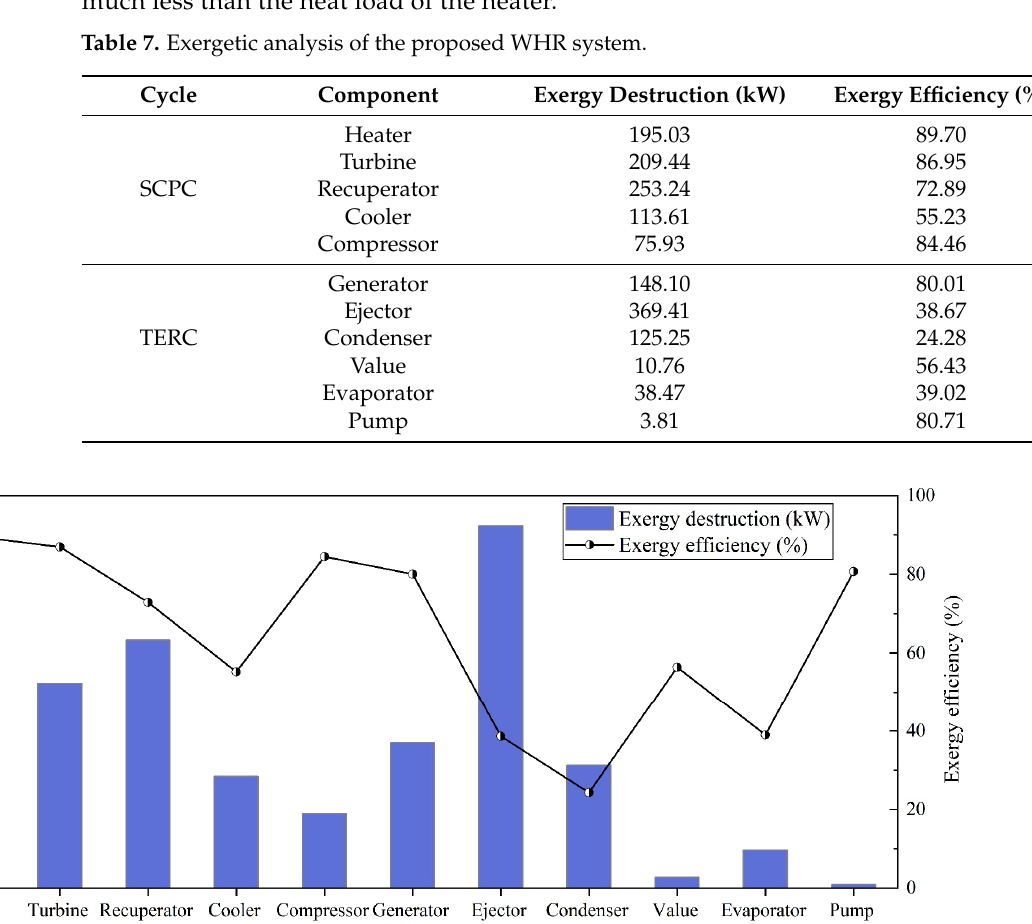
Figure 5. The influences of compressor inlet pressure and pressure ratio on the performance of the SCPC. the